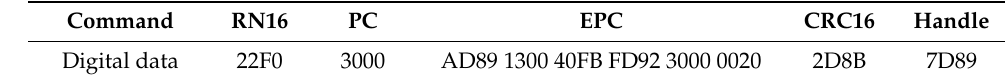
Table 2. The digital data inside the commands.